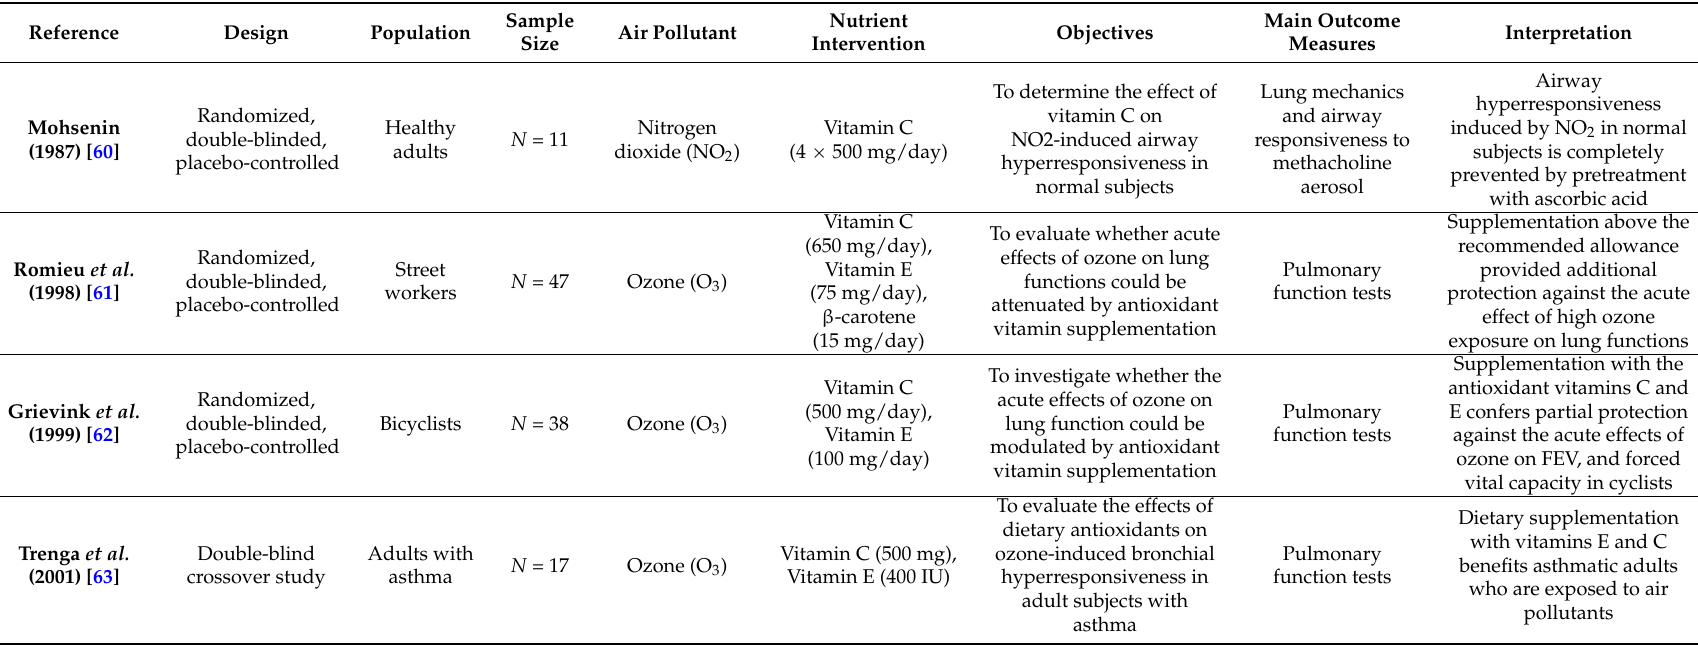
Table 1. Human clinical studies demonstrating the protective effects of nutrients in air pollutant